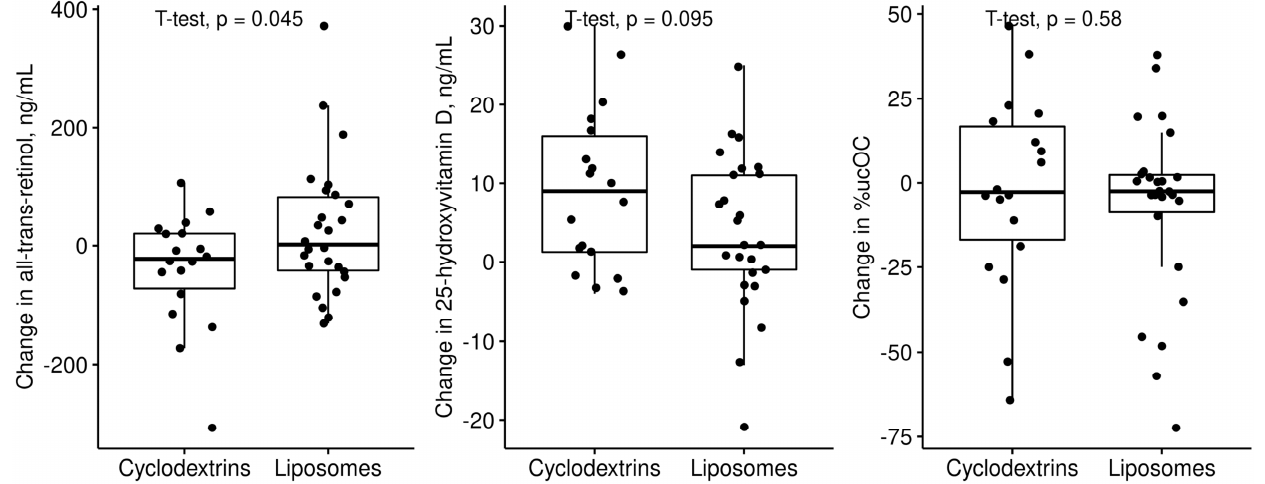
Figure 3. Changes in concentrations of all-trans-retinol and 25-hydroxyvitamin D, and the percentage of undercarboxylated osteocalcin (ucOC%) in PI patients with CF during the trial of the liposomal and cyclodextrin forms.